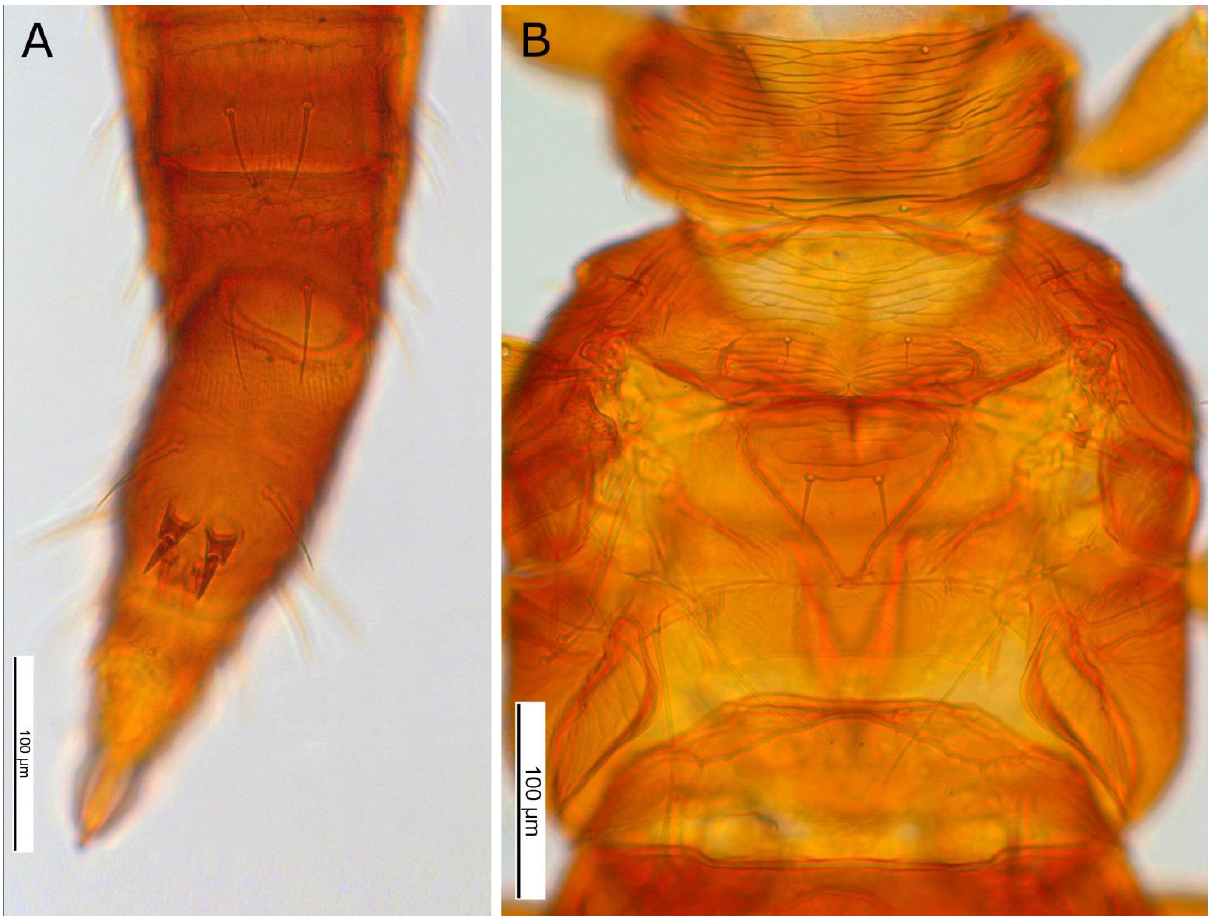
Figure A2. ( A ) tergites VII-X of male S. rubrocinctus ; specimen collected from Carpinus betulus at Bagnolo Cremasco, 2019; ( B ) thoracial nota of female S. rubrocinctus , specimen collected from Liquidambar styraciflua at Pandino, 2019. Photos G. Vierbergen.